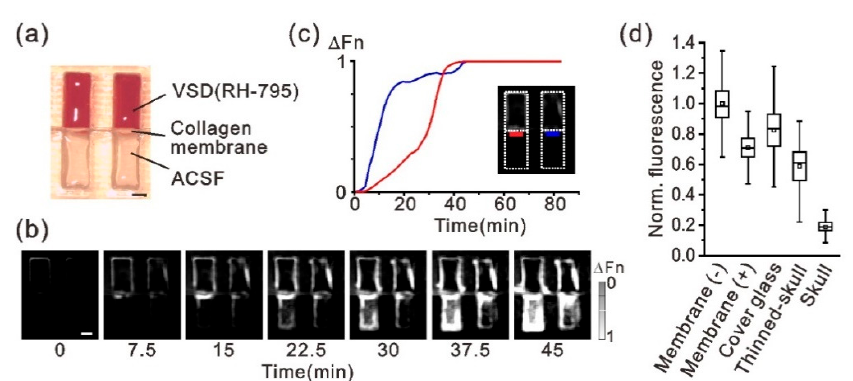
Figure 2. Chemical and optical transparency of the collagen membrane. ( a ) Photograph of two test tubes. The upper and lower parts of the tube well were separated by the collagen membrane; one part was filled with RH-795 VSD and the other with artificial cerebrospinal fluid (ACSF). Thereafter, time-lapse VSD imaging was conducted to show the time course of the di ff usion of the VSD. ( b ) Time-lapse VSD images showing dye di ff usion across the collagen membrane toward the ACSF. Each gray-scale frame indicates the change in dye fluorescence from t = 0. The gray-scale bar represents the peak-normalized ∆ F / F value ( ∆ Fn). ( c ) Time changes in the fluorescence amplitude measured near the collagen membrane on the side with ACSF solution. The traces are from pixels selected in the red and blue rectangular areas in the inset image. ( d ) Optical transparency of the collagen membrane. Fluorescence intensity from the VSD was compared among the following conditions: presence ( + ) and absence (-) of the collagen membrane, cover glass (thickness 120–170 µ m), thinned skull (100–150 µ m), and normal skull (450–500 µ m). The small square in each box plot indicates the mean. Scale bars in ( a ) and ( b ), 1 mm.